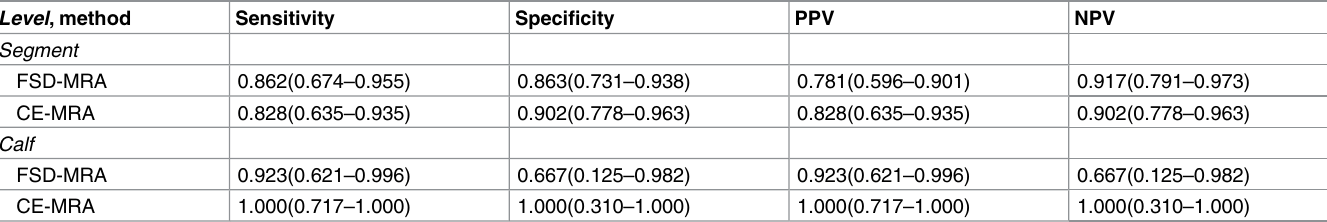
Table 5. Diagnostic accuracy(95%CI) of FSD-MRA and CE-MRA, relative to DSA as a referencestandard.